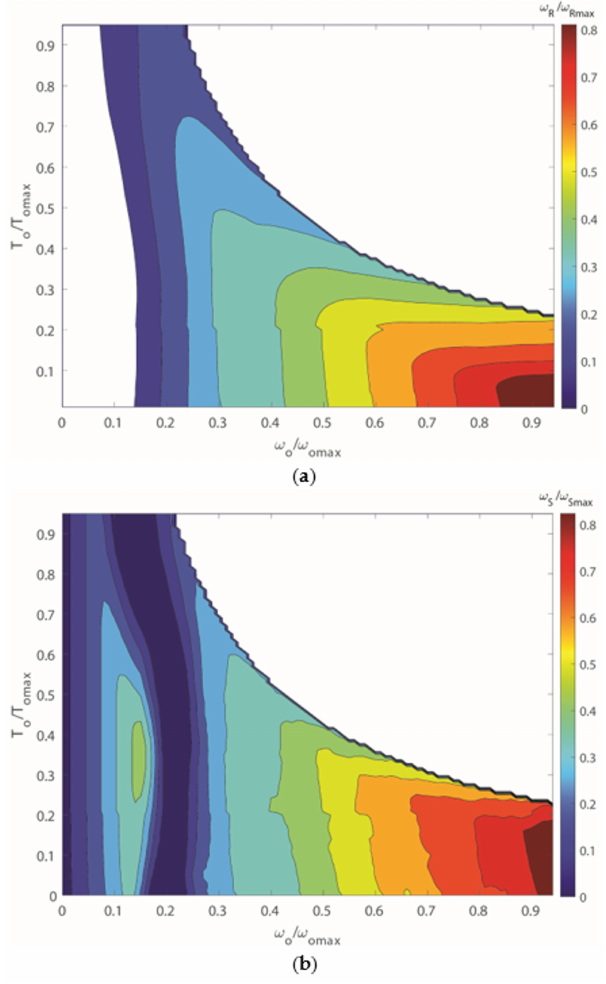
Figure 11. Optimal speed profiles that ensure efficiency maximization for the power supply stage over the Artemis DC: ( a ) ring motor; and ( b ) sun